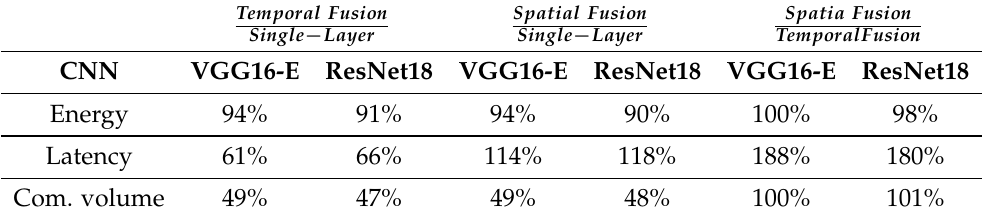
Table 5. Energy, latency, and off-chip to on-chip communication volume comparison with the sum of single- and inter-layer scheduling of the sequences of layers reported in Figures 14 and